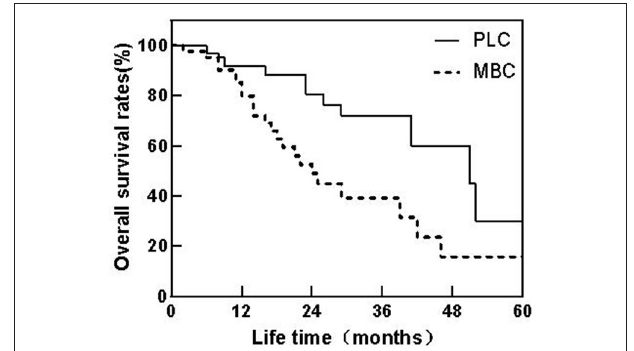
FIGURE 1 | Patient survival curves of PLC and